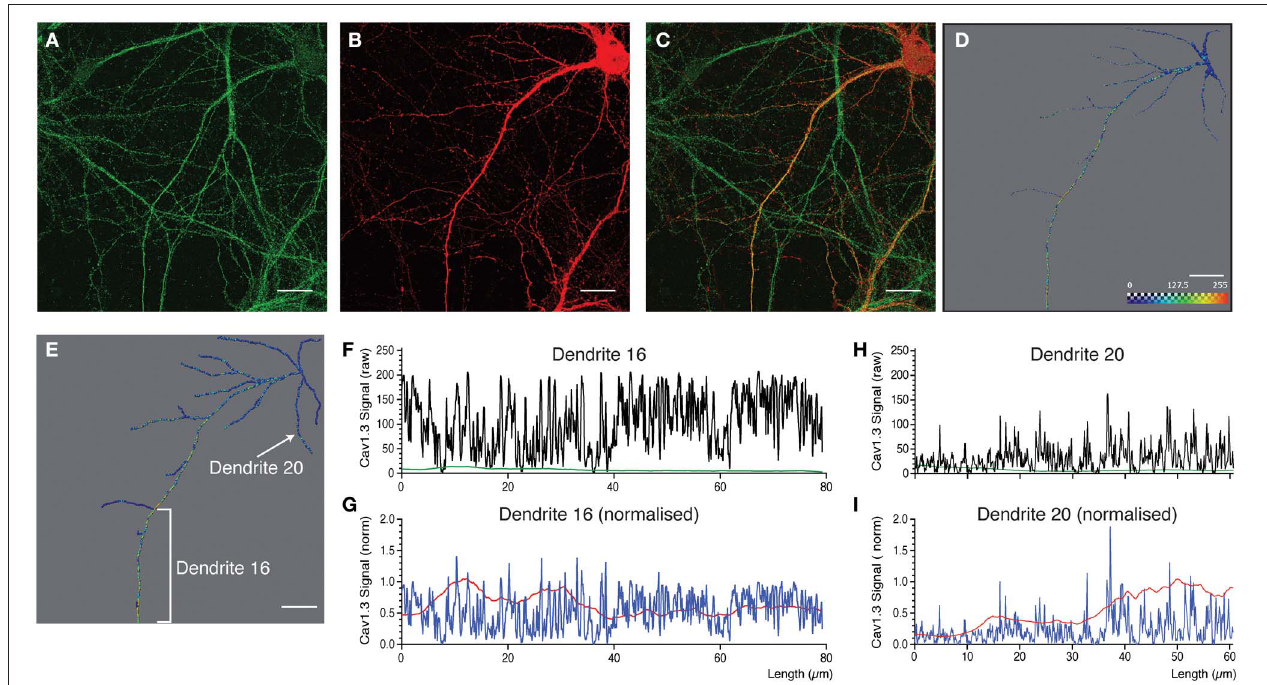
FIGURE 6 | Quantitative analysis and 3D profiling of endogenous Cav1.3 signal in cultured neocortical neurons. (A,B) Image stacks corresponding to endogenous Cav1.3 signal (A) and morphological label (mCherry expression) (B) . (C) Overlay of images in ( A and B ). Images are z-projections derived from maximum signal intensity across 24 focal planes. (D,E) Amira images showing reconstructed dendritic skeleton overlaid with 3D ion channel profile derived from point fluorescence values calculated along the